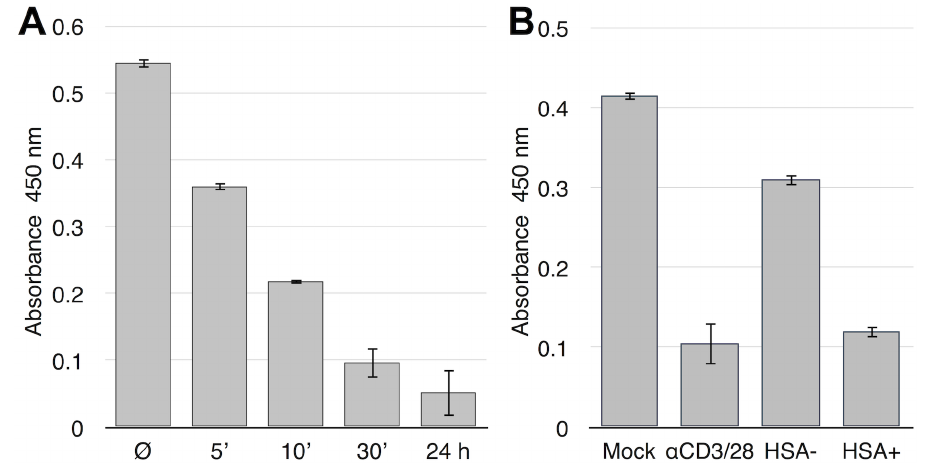
Figure 5. Foxo1 activity by TransAM ELISA. A. Time course of Foxo1 inactivation following T cell activation with anti-CD3/CD28 beads. The ability of nuclear Foxo1 to bind a target DNA oligonucleotide was analyzed using a TransAM Foxo1 kit (Active Motif). SD of triplicate analysis of each condition are shown from one representative experiment of 3. Specificity was demonstrated by successful competition with a free Foxo1 binding oligonucleotide but not with a negative control oligonucleotide (not shown). Error bars are SD of triplicate wells. B. Foxo1 activity in HIV-1 infected resting CD4 T cells, mock infected and beads activated cells. Cells were infected with HIV-1 HSA reporter virus for 7 days, then separated into HSA + and HSA-negative subsets using an antibody to HSA and magnetic beads. Data are from one representative experiment of three independent experiments. Error bars are SD of triplicate wells.